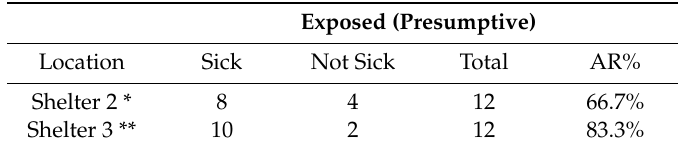
Table 1. Attack rates (AR) for selected rooms and dates where widespread or complete exposure was suspected.